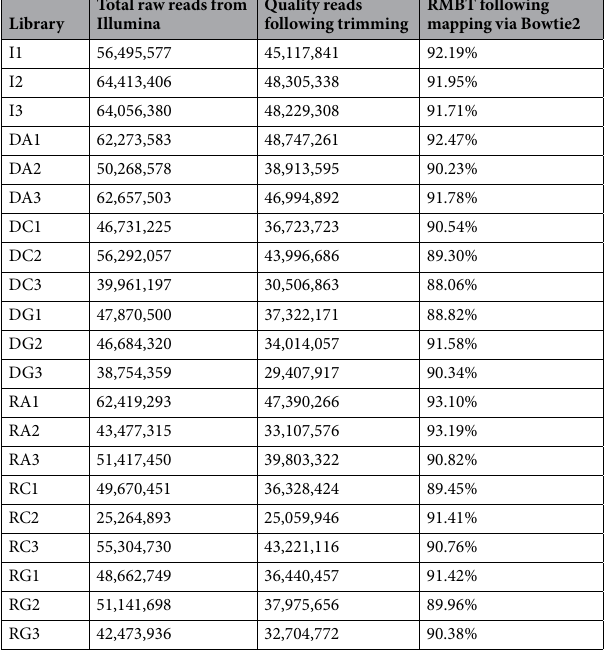
Table 1. Raw reads, reads following trimming and reads mapped back to transcriptome (RMBT) for three technical replicates of G . lateralis intact/intermolt (I), ESA control (D), and rapamycin treated (R) libraries.